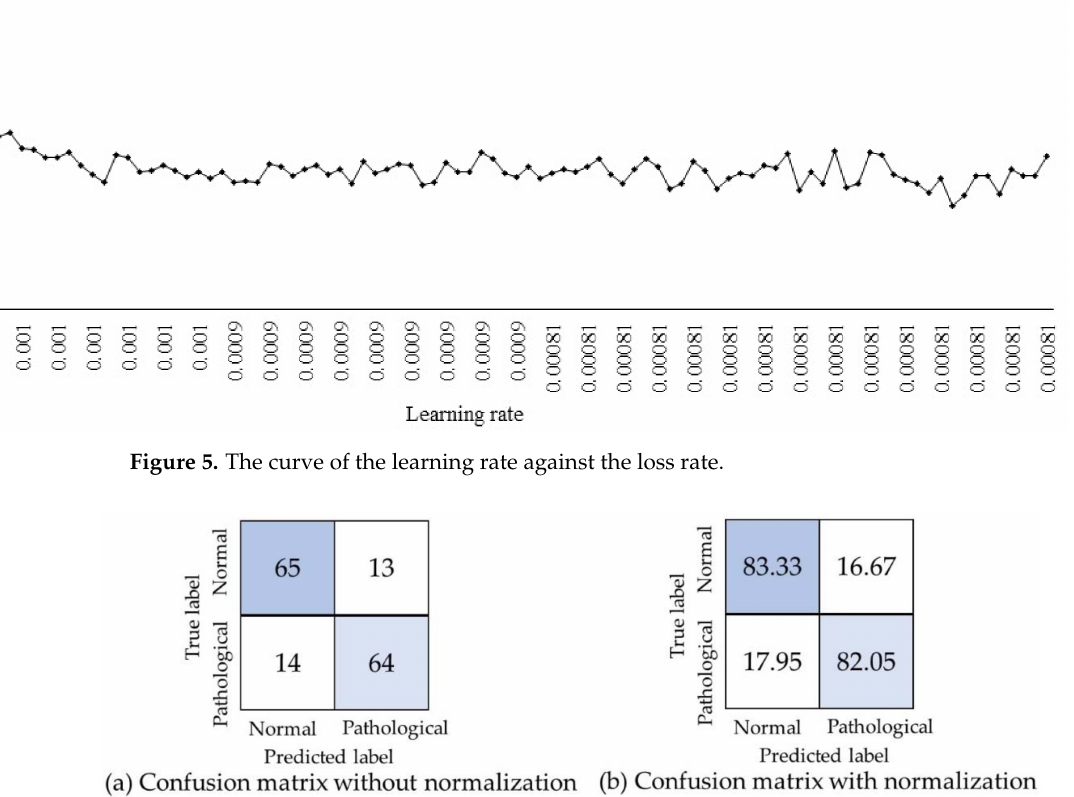
Figure 6. Classification results from the proposed combination of CNN and LPCCs in voiced /u/ vowels in